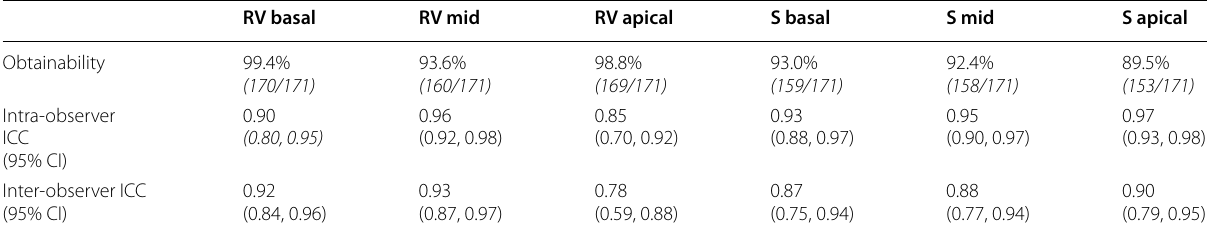
Table 2 Obtainability and reproducibility of strain measurements per segment